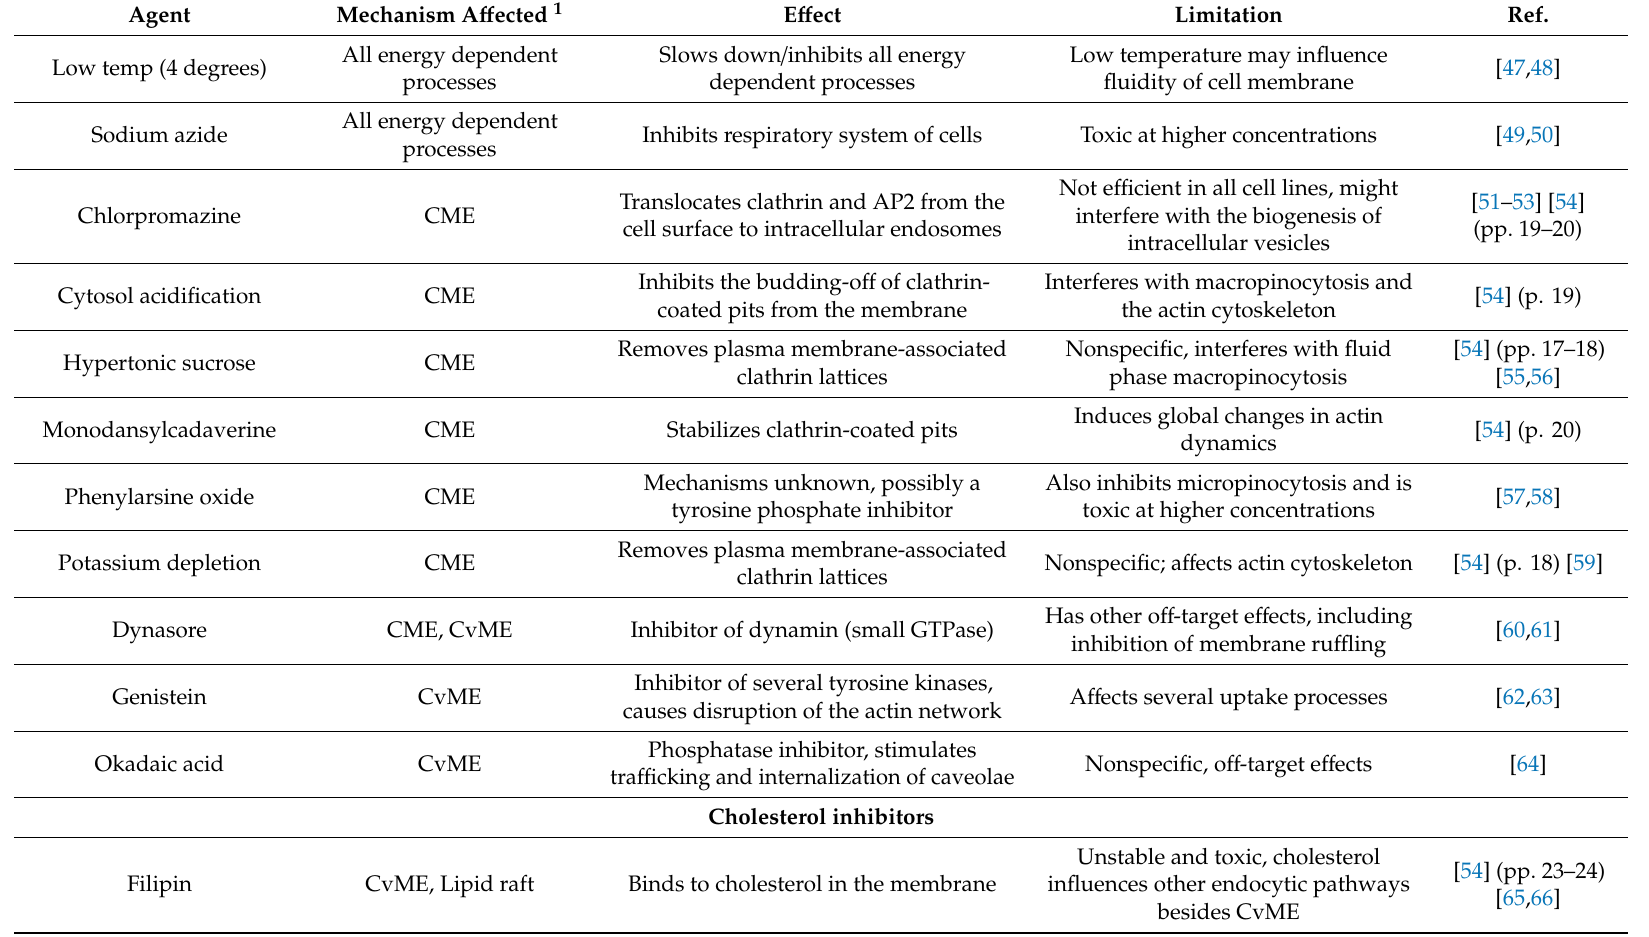
Table 1. Overview of commonly used endocytic inhibitors, their e ff ects and limitations